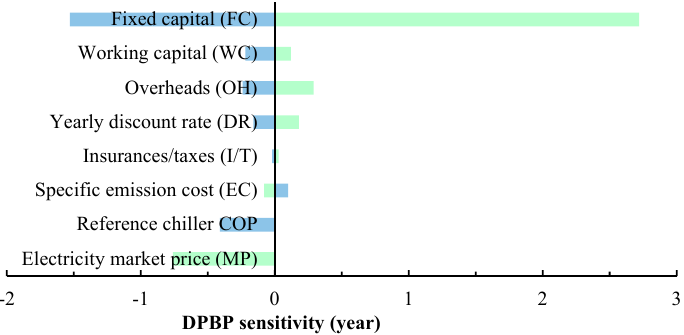
Figure 10. Sensitivity of the discounted payback period (DPBP) to ± 50% variation in monetary parameters relative to their nominal values in Table 8 for the local electricity market price.